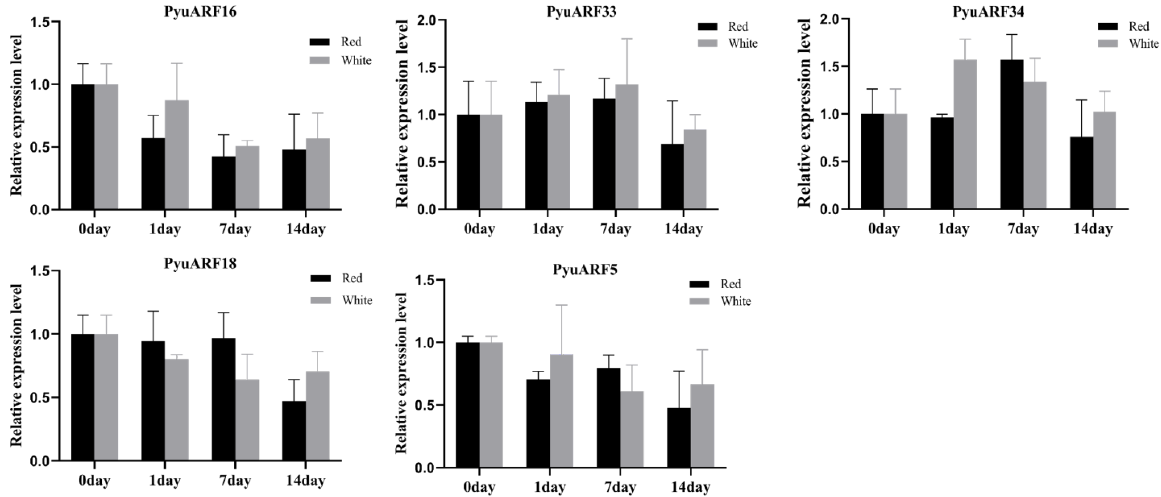
Figure 9. Transcription profiles of 5 PyuARFs with high expression in the stem under light. The abscissa represents the days of treatment, and the ordinate represents the transcription profiles of the genes.